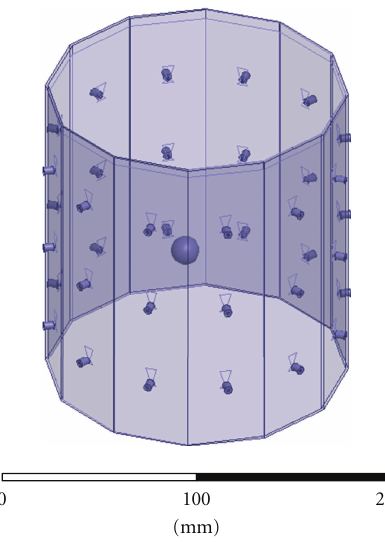
Figure 9: HFSS model of a simple sphere used to generate synthetic scattered field S